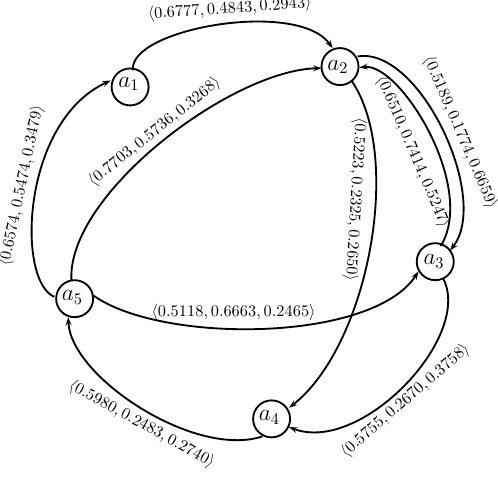
Figure 8. Partial directed network of the fused